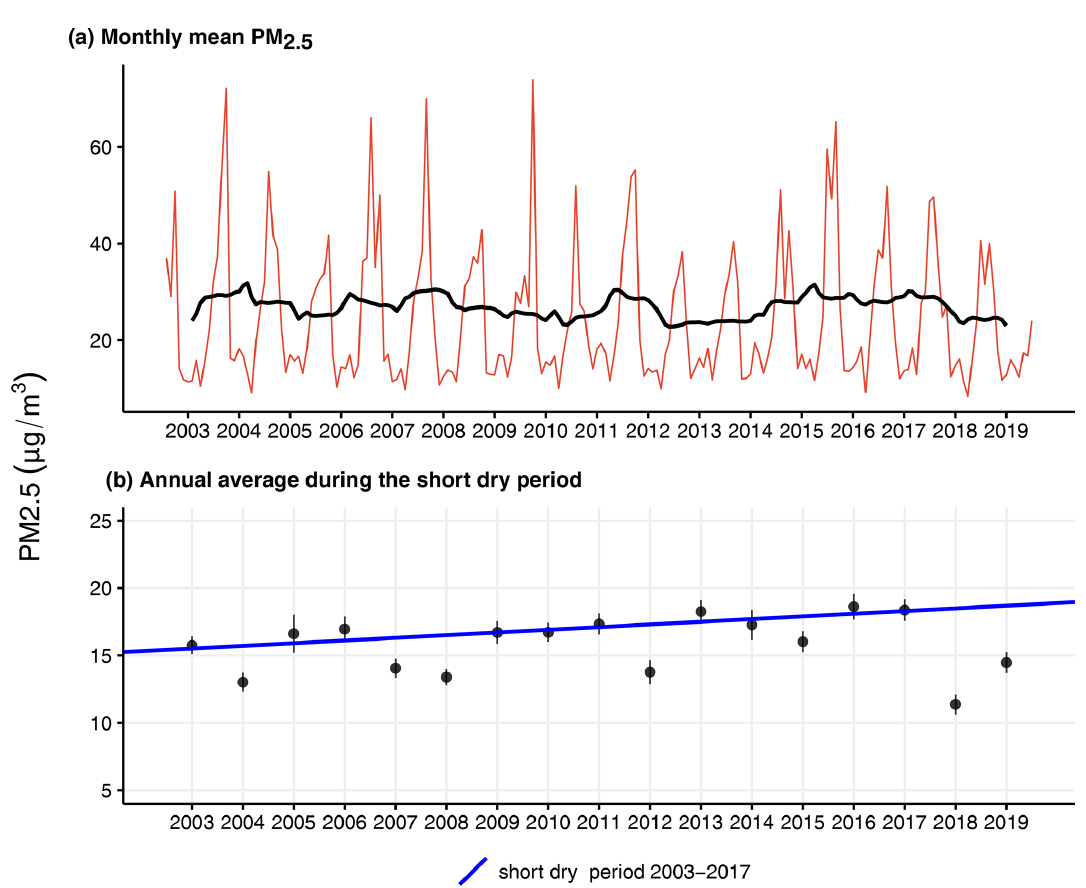
Figure 11. MODIS-derived PM 2 . 5 from 2003 to 2019. (a) Monthly mean over SWA and seasonal adjusted trend, (b) annual average during the short dry period and monotonic trend computed over